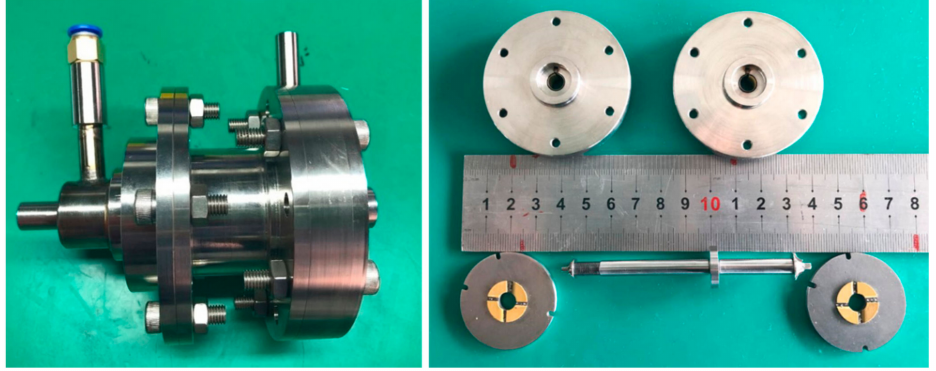
Figure 4. CO 2 turbo-expander by Xi’an Jiaotong